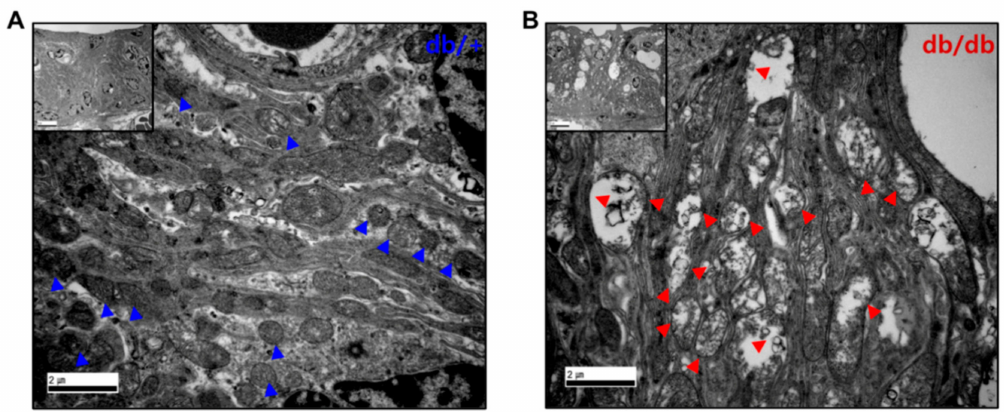
Figure 6. TEM images of the cochlear stria vascularis (SV). ( B ) Stria vascularis of db/db mice exerted small vacuolization and gaps between the strial cells. Mitochondria appeared swollen and distorted with reduced cristae in the SV of db/db mice ( B ), red triangles compared to db/+ animals ( A ), blue triangles. Scale bar = 2 µ m, insert, 5 µ